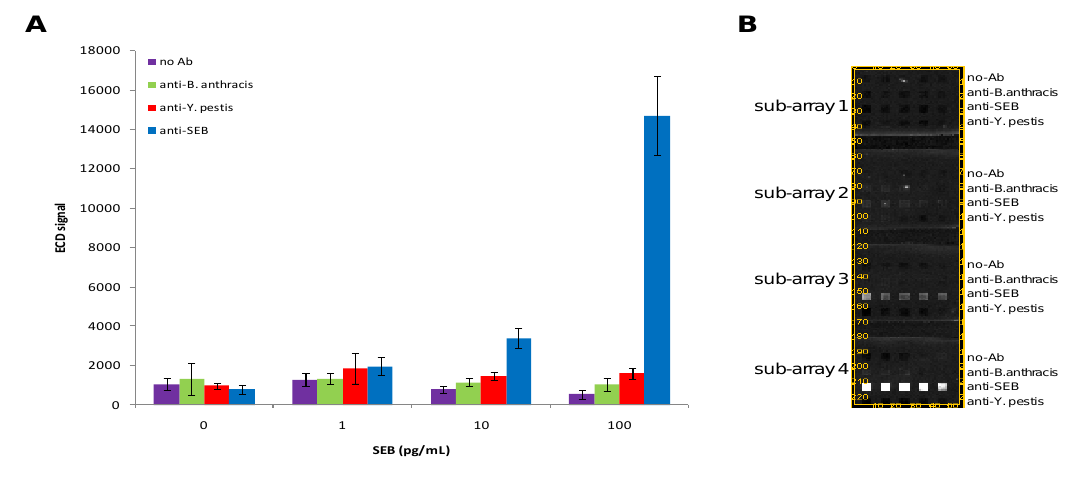
Figure 2. Electrochemical detection (ECD) assay for SEB. Antibody microarrays were incubated with 0 pg/mL, 1 pg/mL, 10 pg/mL, or 100 pg/mL SEB. Anti- B. anthracis , anti- Y. pestis , and anti-SEB refer to the antibodies immobilized on the chip surface. ( A ) Mean signals and SD; ( B ) Image of microarray.